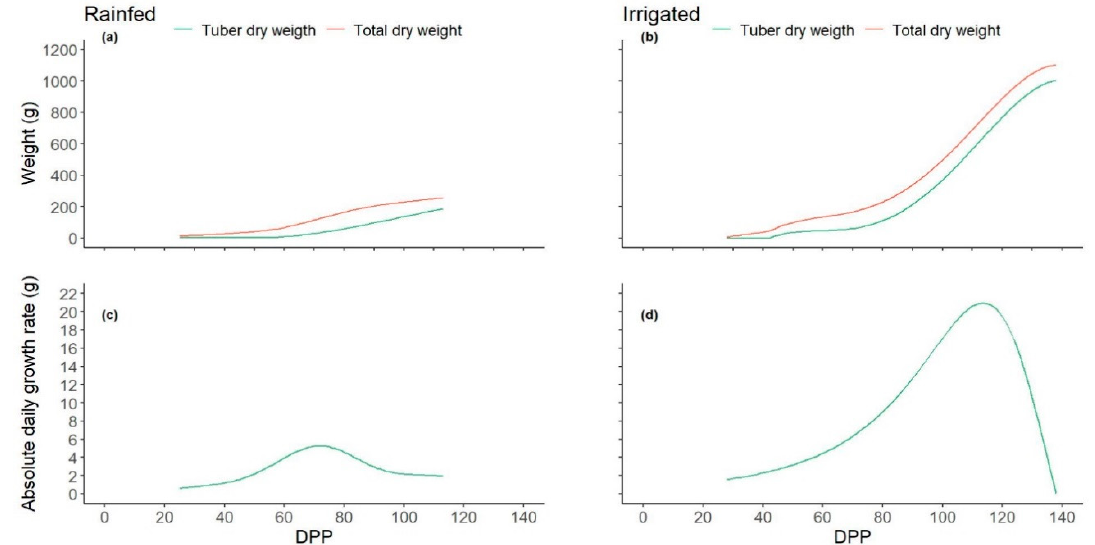
Figure 7. Dry weight (DW) and tuber dry weight (TDW) in ( a ) Rainfed and ( b ) Irrigated; absolute growth rate (AGR) in ( c ) Rainfed and ( d ) Irrigated.